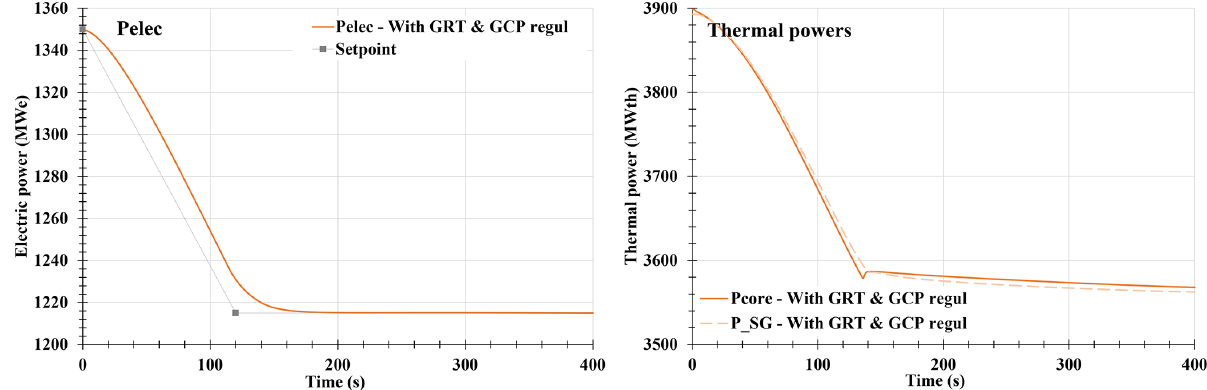
Fig. 3. Electrical and thermal powers (core Pcore and steam generator P_SG) during a load following